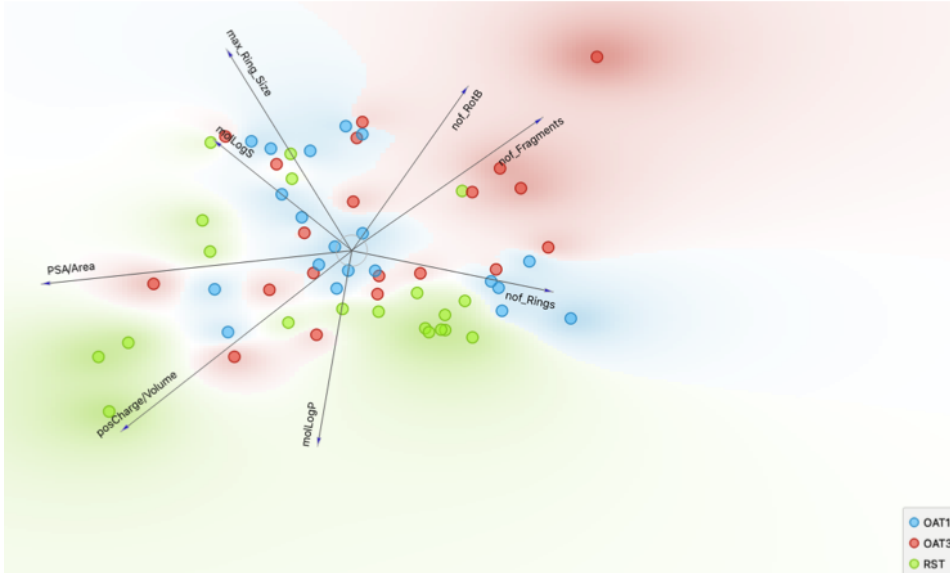
Figure 3. FreeViz vector plot of the molecular features of increased metabolites in OAT1, OAT3, and RST (Urat1). Each axis corresponds to a different physical/biophysical measurement; the length of each axis corresponds to the magnitude of the feature and the angle between any two axes corresponds to the correlation between the features [22]. Green circles represent the RST KO and the red and blue circles correspond to the Oat1 and Oat3 KO,